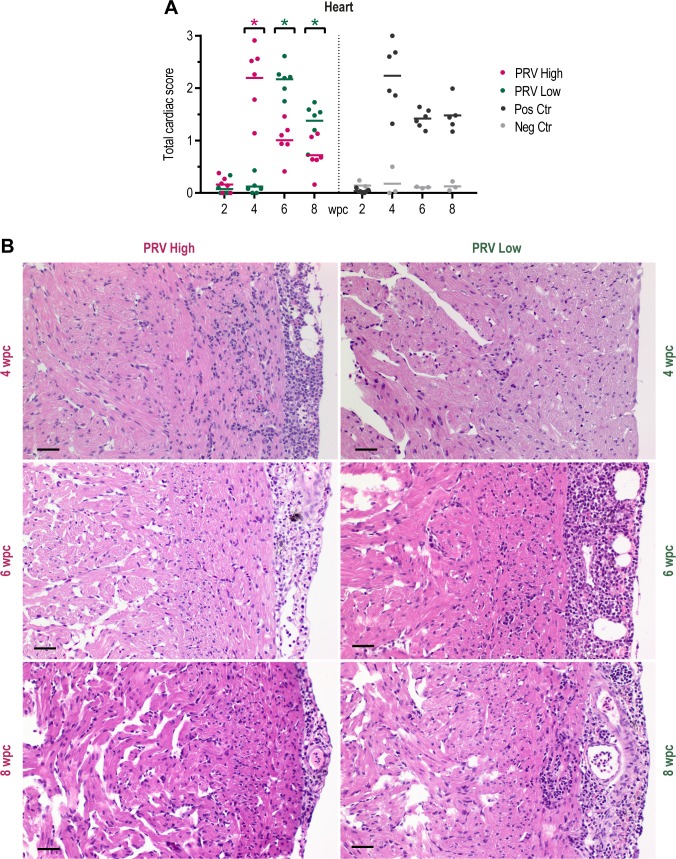
Histopathological lesions consistent with HSMI detected in the heart.Histopathology in the heart of fish injected with purified PRV in challenge experiment #2. (A) Histopathological score shown as individual score (total cardiac score) and group mean from 2 to 8 weeks post challenge (wpc) for the PRV-High (red), PRV-Low (green), positive control (black) and negative control (grey) group (n = 6). Statistical analysis comparing PRV-High and PRV-Low was performed using Mann-Whitney test at each time point, *p < 0.05, asterisk color (red and green) indicate the significantly higher group. (B) Light microscopic images of cardiac histopathology in representative fish at 4, 6 and 8 wpc from PRV-High (red) and PRV-Low (green) to illustrate development of HSMI. Ventricle showing epicarditis and myocardial inflammation in the compact myocardium. Scale bar 20 μm.